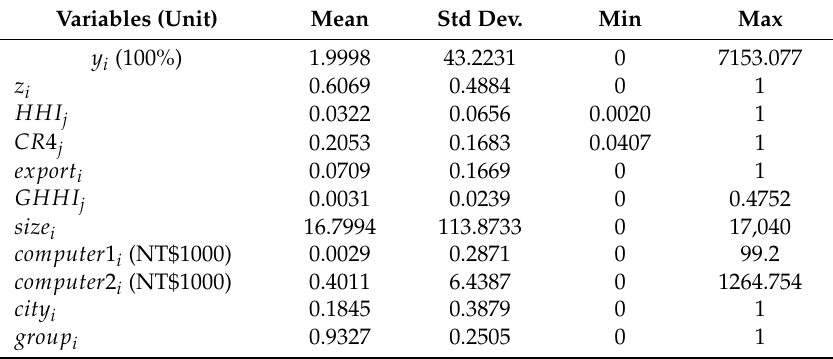
Table 3. Descriptive